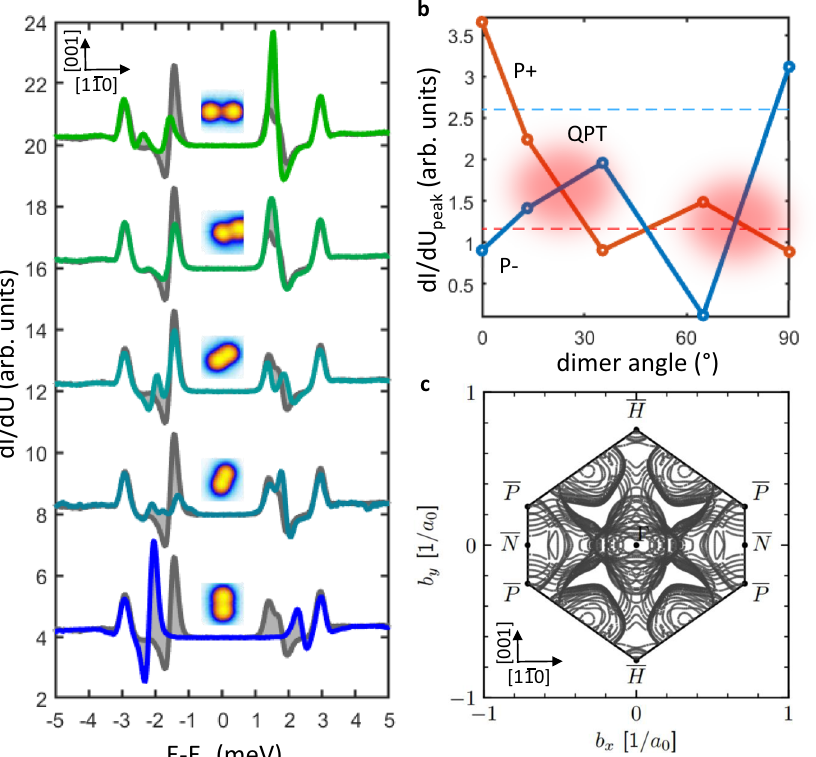
Fig. 2 Directional dependence. a STS spectra taken on atom A for different positions of atom B. STS on the isolated reference atom is shown in gray. Curves are vertically shifted for clarity. Insets: topography images 2 × 2 nm of the corresponding Cr dimers. b Maximum intensity of the in-gap peaks in the positive (red) and negative (blue) energies with respect to the Fermi level as a function of the dimer angle where 0° means parallel to the 1 (cid:1) 10 Transfer of spectral weight between positive and negative energies with highlighted quantum phase transition. c Fermi surface of Nb(110)